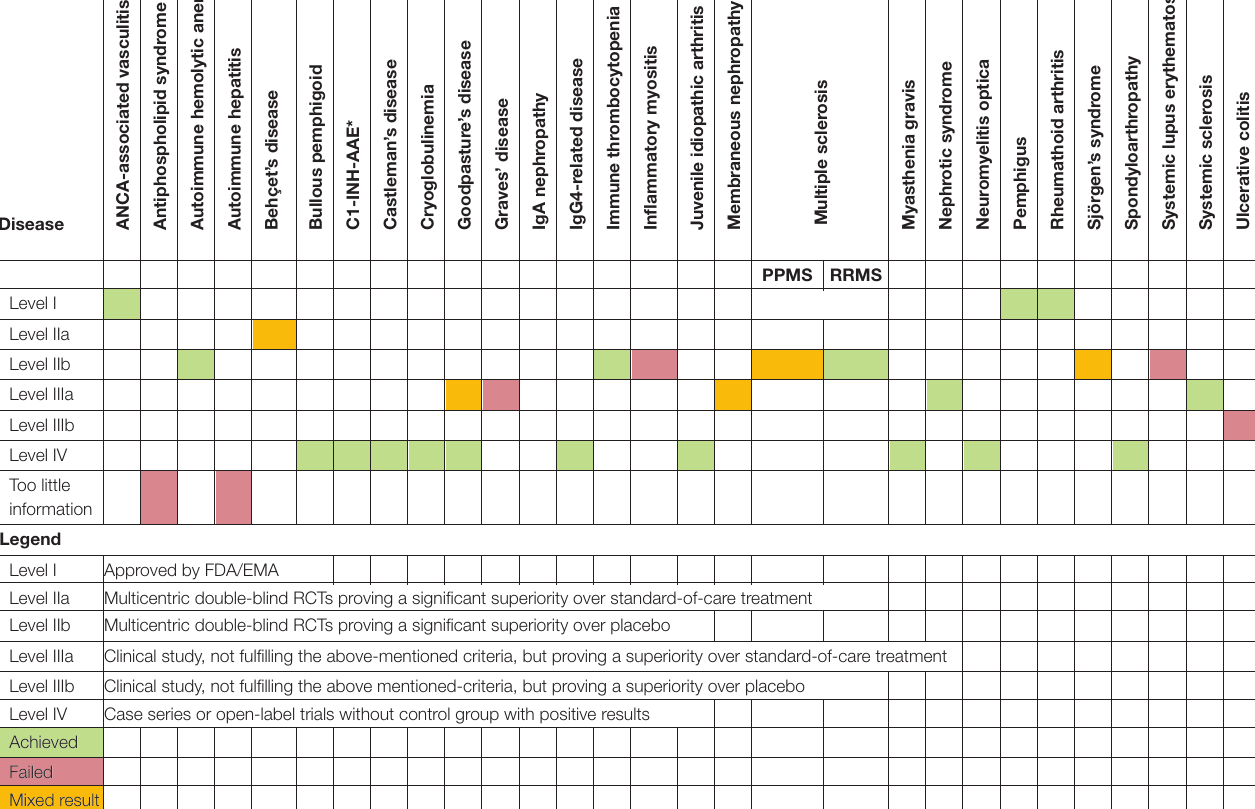
TABLE 3 | Summary of the results.